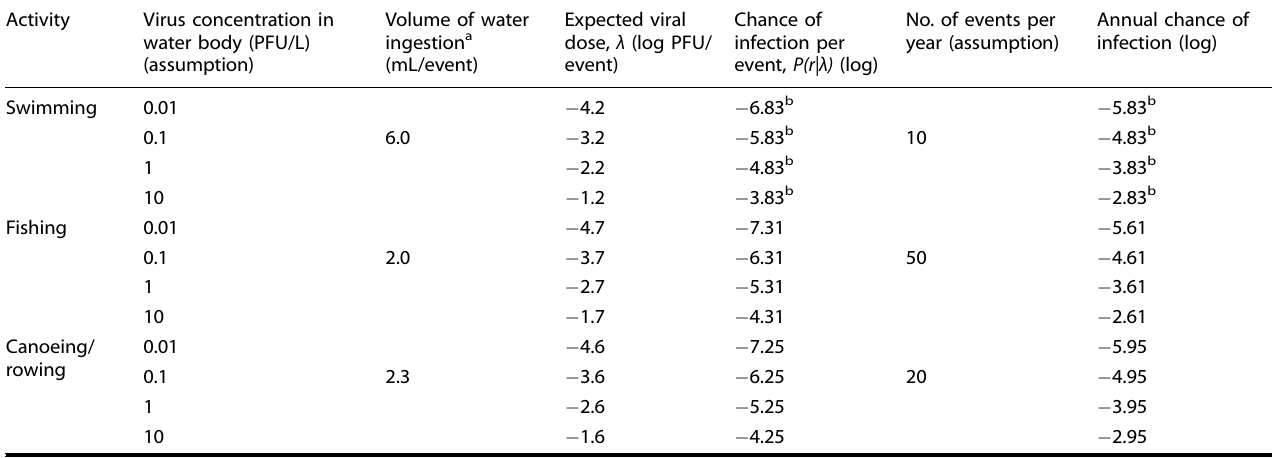
Table 1. (Corresponding to Table 3 in the original article): Expected dose and probability of infection to SARS-CoV-2 for various water activities under various viral concentration